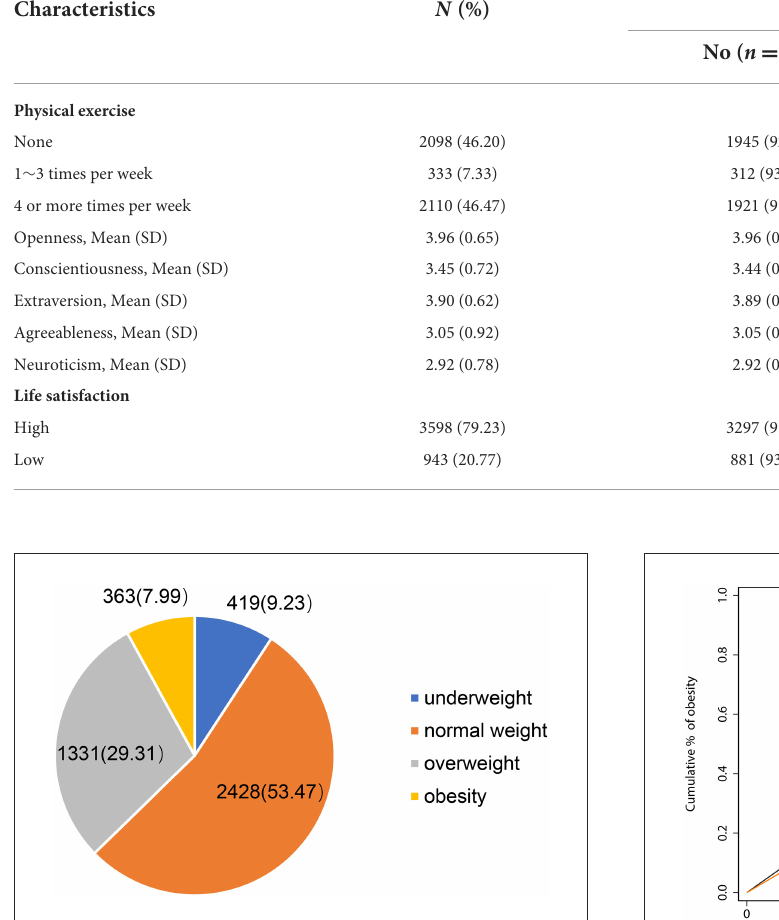
FIGURE1 Distribution of BMI of the elderly in China, 2018 ( N = 4541).